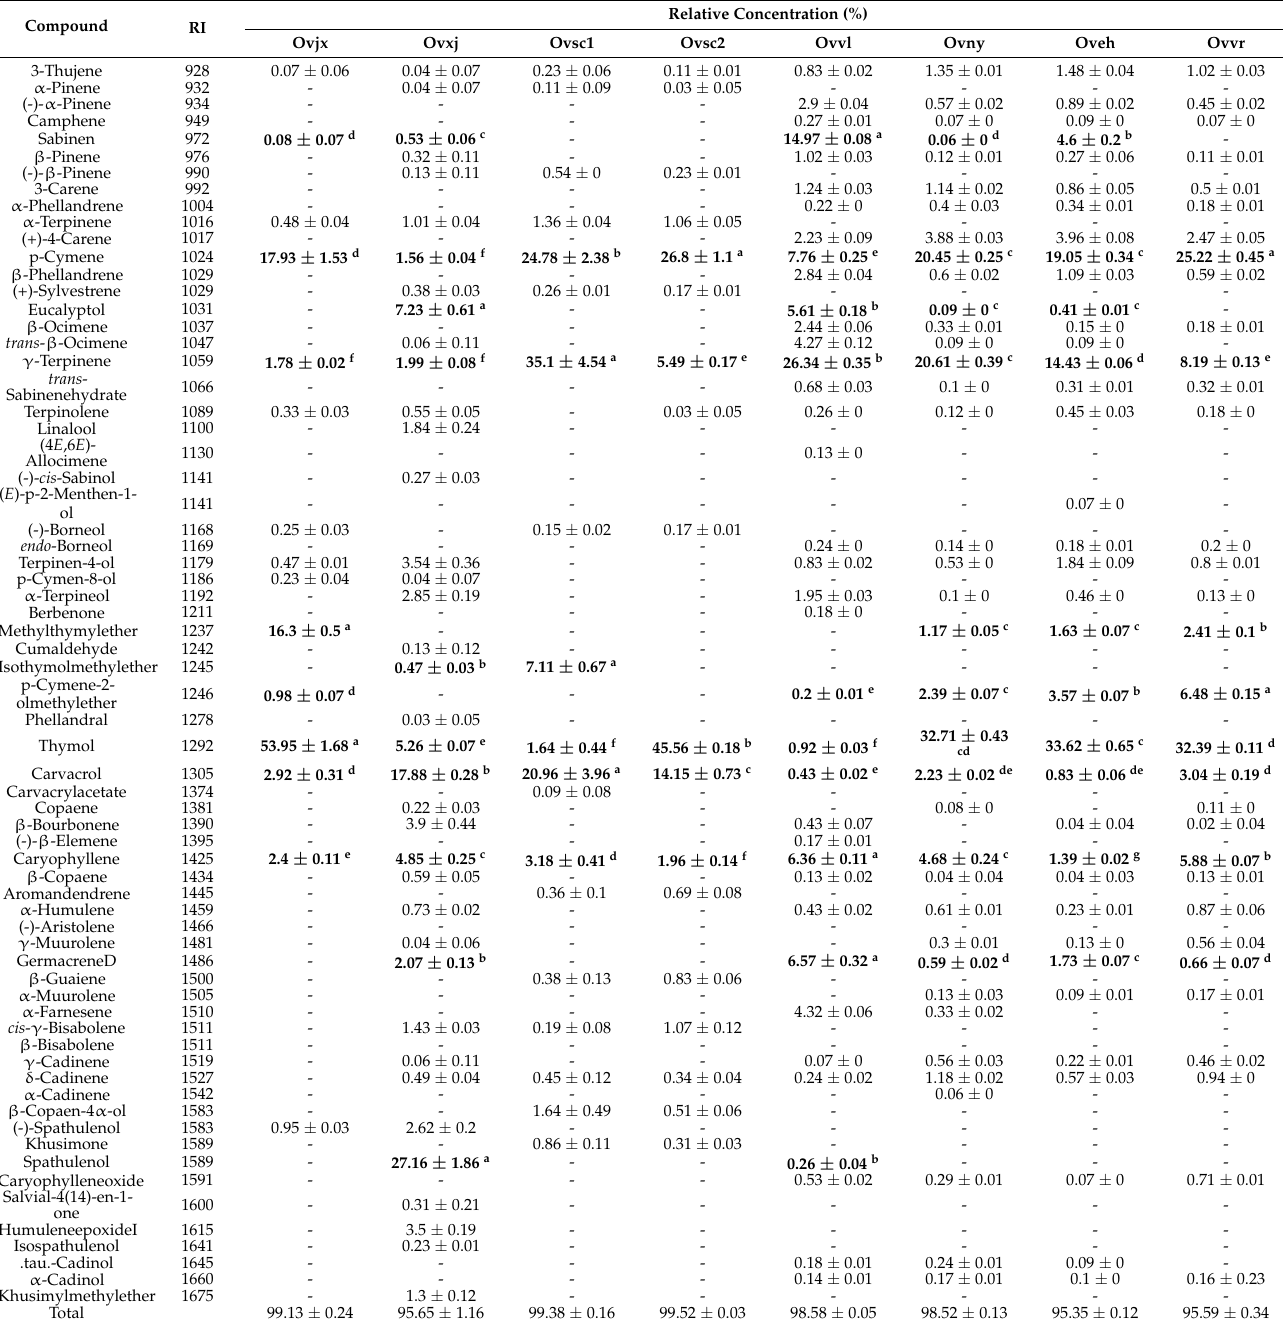
Table 1. Chemical composition of essential oils from eight oregano